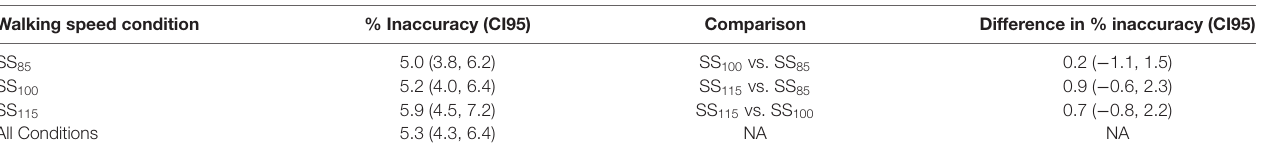
TABLE 2 | Inaccuracy percentage for each walking speed condition using the MR-HMD. Walking speed